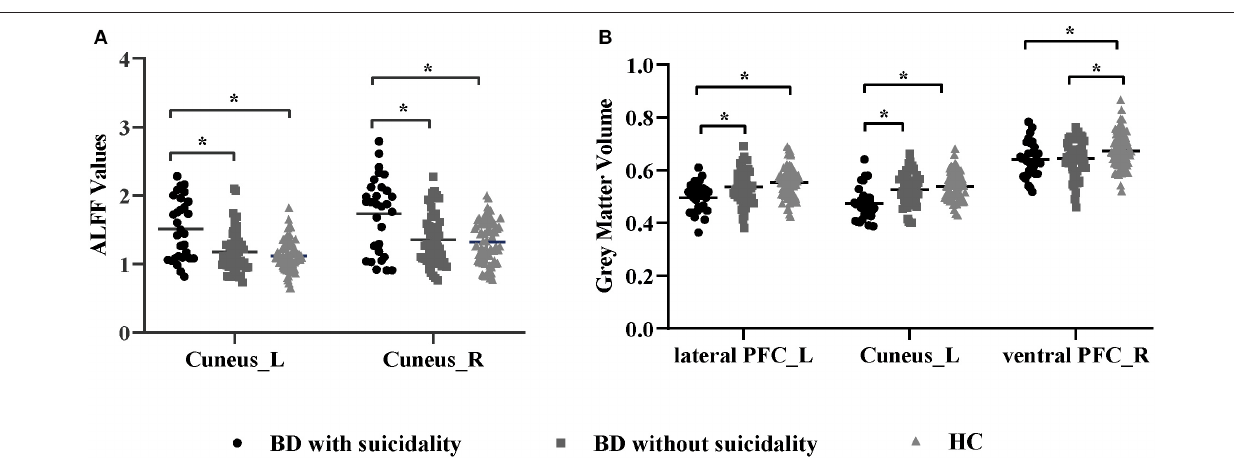
FIGURE 3 | (A) ALFF values in regions showing significant differences among the BD with suicidality, BD without suicidality, and HC groups. (B) Gray matter volume in regions showing significant differences among the BD with suicidality, BD without suicidality, and HC groups. The significance level was set to P < 0.05 by Bonferroni corrected. * P < 0.05. ALFF, amplitude of low-frequency fluctuation; BD, bipolar disorder; HC, healthy controls; L, left; R, right; PFC, prefrontal